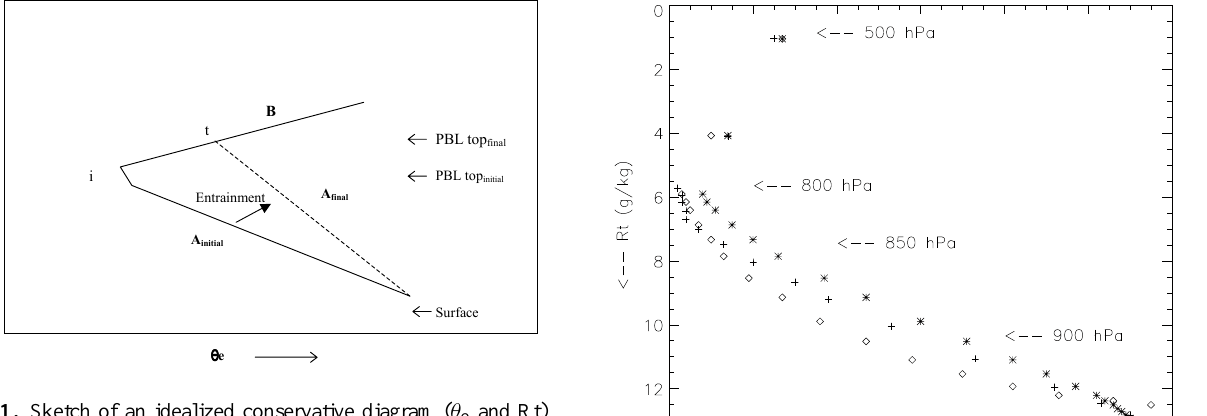
Fig. 11. Sketch of an idealized conservative diagram ( θ e and Rt) which shows the effect of entrainment at the top of the PBL. A initial is the initial mixing line, A final is the final mixing line, i marks the initial position of the PBL top and t marks the final PBL top; B marks the line segment representing the free atmosphere.